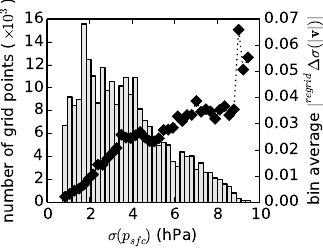
Figure 17. Histogram of σ(p sfc ) , overlain with the bin-averaged difference of σ(p sfc ) against the differences between σ( | v | ) com- puted from a vertically regridded ensemble and computed from the original member grids. Same forecast as in Fig.